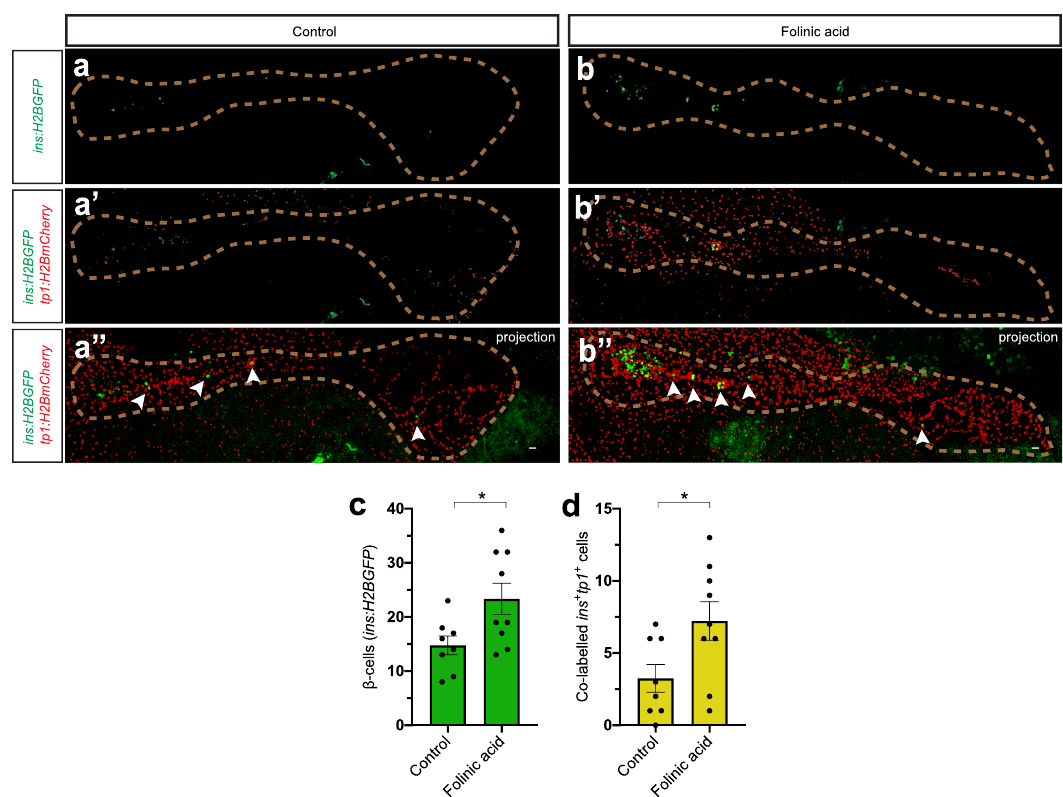
Fig. 5 Folinic acid stimulates β -cell regeneration in juvenile zebra fi sh. a – d Single-plane and maximum projection confocal images of pancreata in control ( a – a ” ) or folinic acid-treated ( b – b ” ) 1-month-old juvenile zebra fi sh on the Tg(ins:H2BGFP) ; Tg(ins: fl ag-NTR) ; Tg(tp1:H2BmCherry) background, following β -cell ablation. Quanti fi cation showed an increase in the number of regenerating β -cells in the secondary islets upon treatment with folinic acid ( c ) as well as an increase in the number of ins:H2BGFP + tp1:H2BmCherry + cells ( d ). The dashed line outlines the pancreas. Arrowheads point to ins:H2BGFP + cells in the secondary islets. Scale bar, 20 μ m. n = 8 (control) and n = 9 (folinic acid) biologically independent zebra fi sh were used for the quanti fi cation of this experiment. Data are presented as mean values± SEM. Unpaired two-tailed Student ’ s t test was used to assess signi fi cance for ( c ) and ( d ). c * P = 0.0264; d * P =